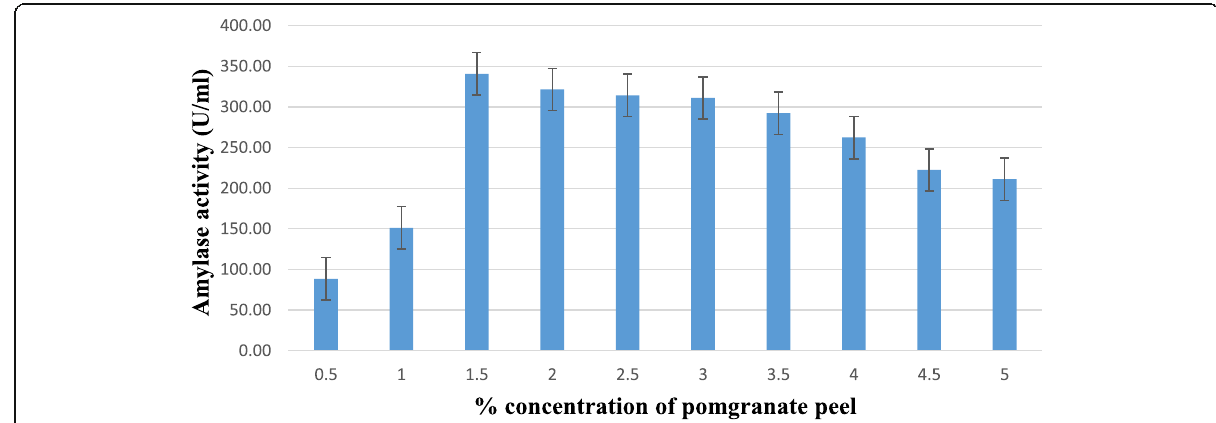
Fig. 3 Effect of different concentration of substrate on α -amylase produced by Aspergillus terrus SS_RS-NE